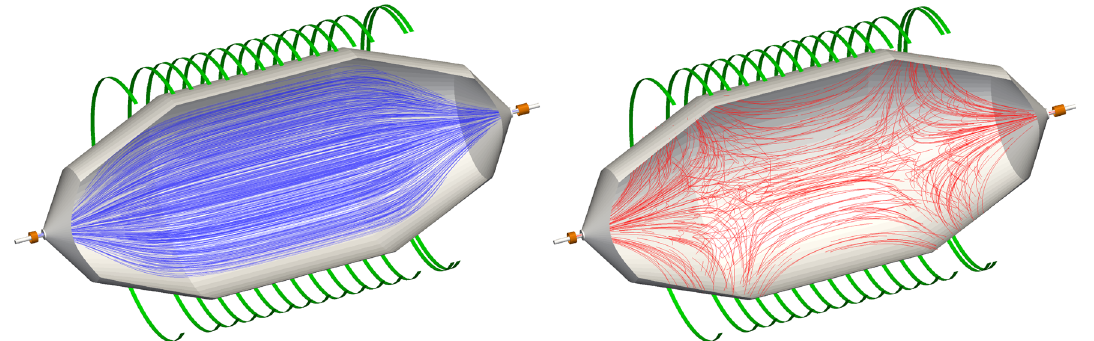
Fig. 2 Deformation of the flux tube by the magnetic pulse method. Left: Under nominal conditions, the 191T cm 2 flux tube (blue field lines) is fully contained inside the main spectrometer vessel. Right: The flux tube is deformed when the magnetic field is reduced by the magnetic pulse. This is achieved by inverting the currents of the LFCS